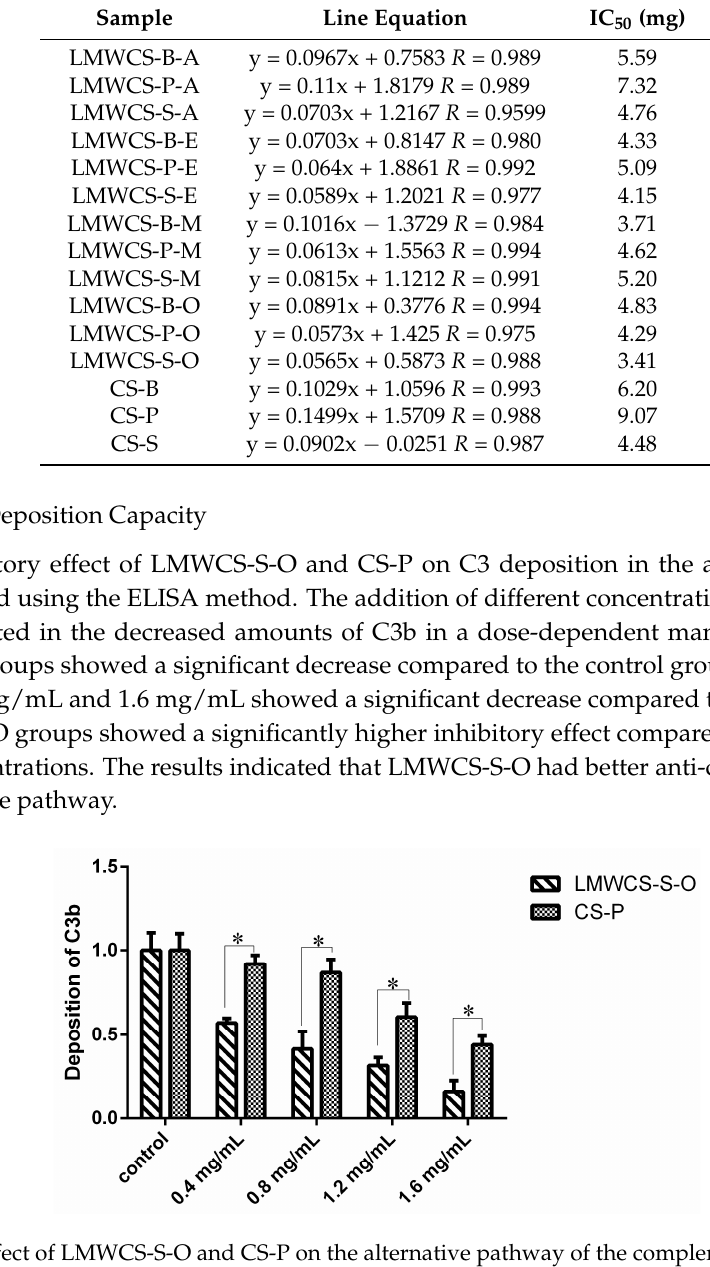
Figure 2. Effect of LMWCS-S-O and CS-P on the alternative pathway of the complement system. All data were normalized by setting the absorbance of the control group to one. (* p < 0.05 vs. CS-P groups).